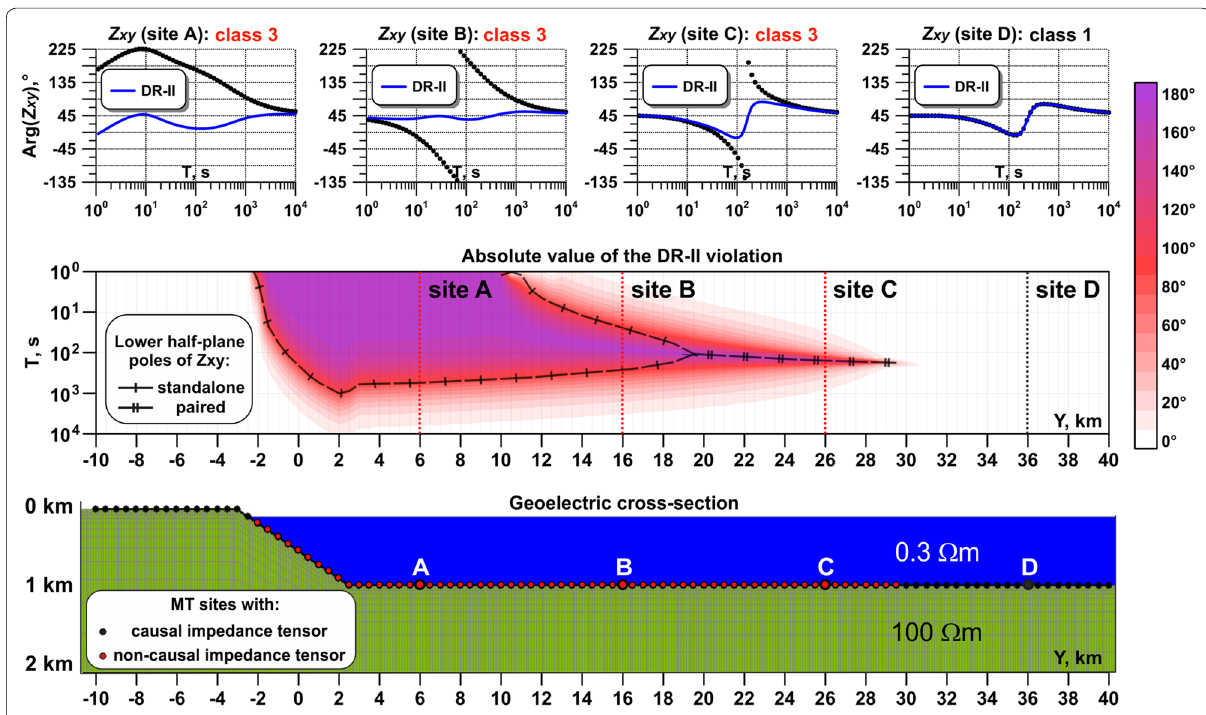
Fig. 8 The DR-II validity in Z xy component observed in E-polarized 2-D model of the coast